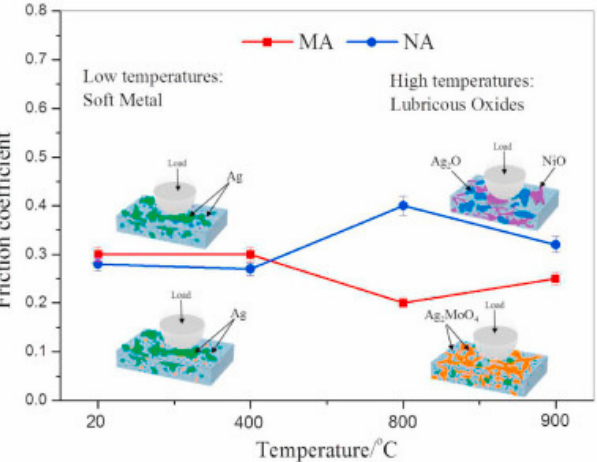
Figure 4. The variation in CoF with temperature and lubrication mechanism for MA and NA alloy. Reproduced with permission from [24]. Copyright Elsevier,